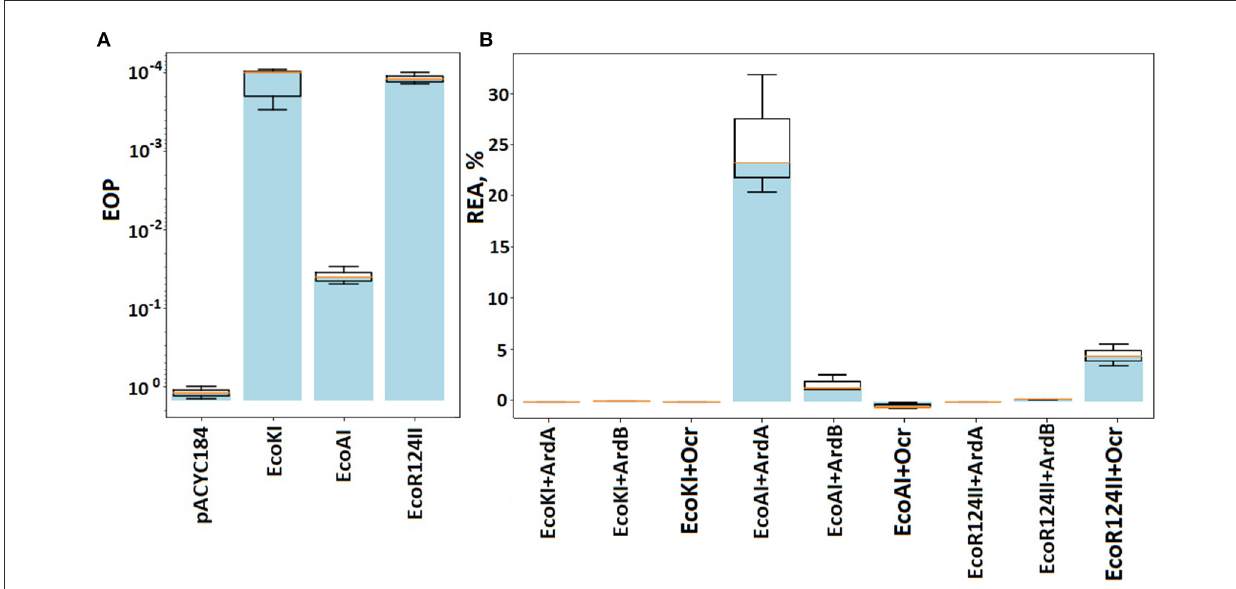
FIGURE1 The efficiency of defense provided by RMI systems. Results of the λ 0 phage plaquing (EOP) on a lawn of E. coli cells containing genes of various RMI systems of gram-negative bacteria. (A) EOP represents a ratio of a phage titer obtained on the experimental lawn relative to the TG1 lawn, which is sensitive to phage infection. Columns: pACYC184 – empty vector TG1pACYC184, EcoKI – TG1pACYCEcoKI, EcoAI – TG1pAM35, and EcoR124II – TG1pKF650. (B) Antirestriction activity of ArdB, ArdA, and Ocr. The residual activity of endonuclease (REA) represents the activity of endonuclease in the presence of ArdB, ArdA, or Ocr. Columns: EcoKI + ArdA – TG1pACYCEcoKIpUCArdA; EcoKI + ArdB – TG1pACYCEcoKIpArdBRam; EcoKI + Ocr – TG1pACYCEcoKIpBADOcr; EcoAI + ArdA – TG1pAM35pUCArdA; EcoAI + ArdB – TG1pAM35pArdBRam; EcoR124II + ArdB – TG1pKF650pArdBRam; EcoR124II + Ocr – TG1pKF650pBADOcr.